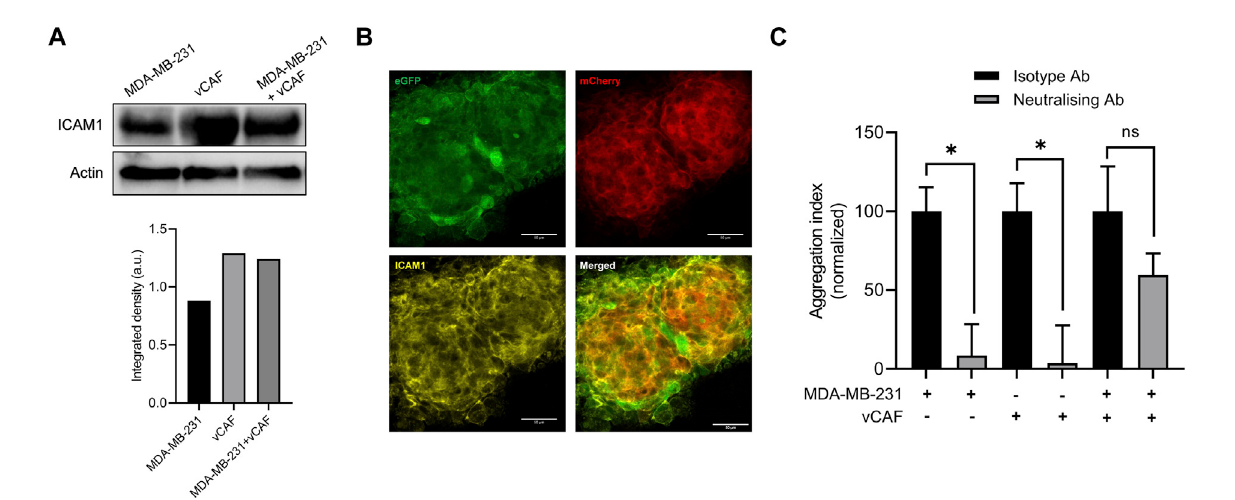
FIGURE 6 Evaluation oftheinvolvementofICAM1 intheformation of het CTC-C. (A) ICAM1 proteinexpressionlevesl bywesternblotinMDA-MB-231 andvCAF monoculturesandco-cultures(top)andquanti fi cation(bottom); (B) RepresentativeimagesofICAM1proteindetectedbyimmuno fl uorescenceinalarge heterotypic MDA-MB-231 — vCAF aggregate (scale bar 50 µm). (C) Effect of an anti-ICAM1 neutralising antibody on the homotypic and heterotypic aggregation of MDA-MB-231 and